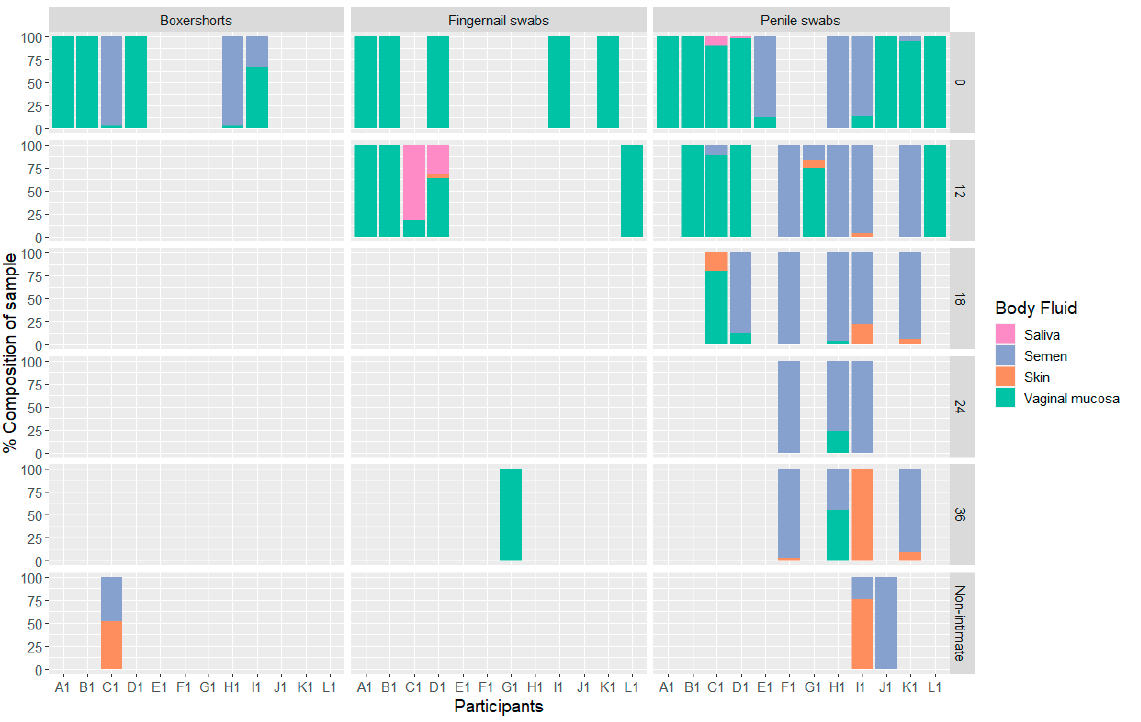
Figure 1. Bar chart showing the percentage of body fluids detected in each sample, divided into participants, sample location and time of sampling, n = 52.